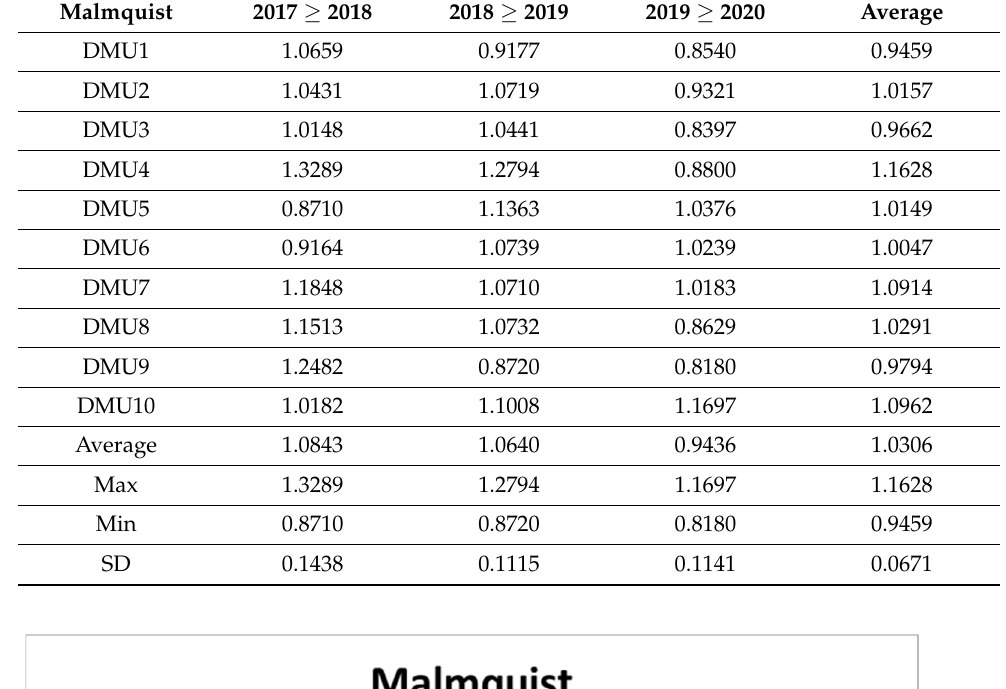
Table 9. The Malmquist productivity index of DMUs (2017–2020).